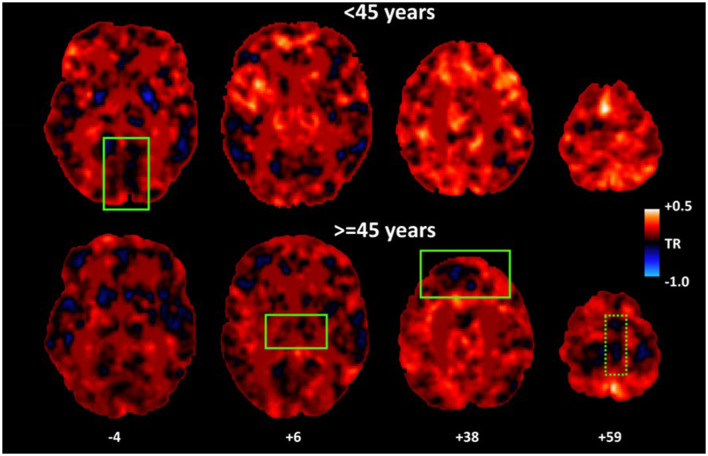
Average maps of hemodynamic lead for younger (<45 years) and older participants (≥45 years). As a group, older adults displayed higher percentage of voxels characterized by hemodynamic lead (as indicated by more cold colors) in vmPFC and thalamus as compared to younger adults. A similar effect in SMA [dotted rectangle] depended upon depression symptoms. Conversely, younger adults displayed lower percentage of voxels displaying hemodynamic lead in inferior occipital cortices.